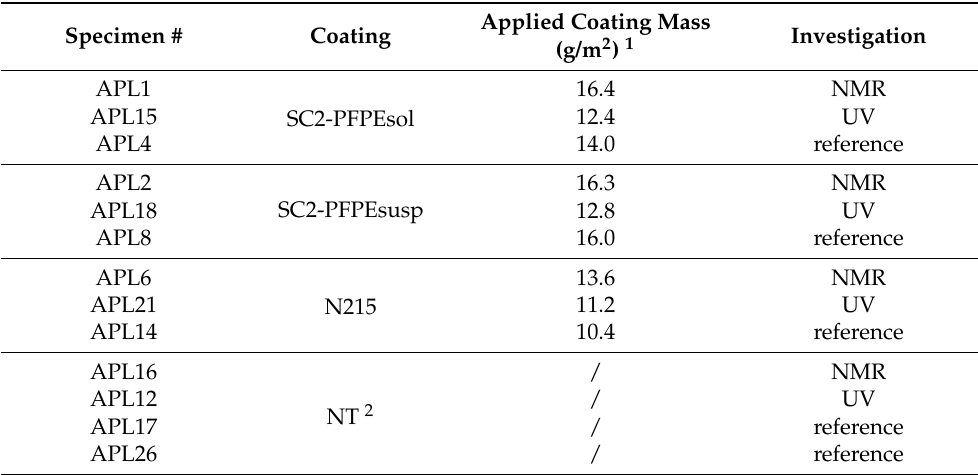
Table 1. Mass of coating applied on Lecce stone specimens and kind of investigation subjected by the